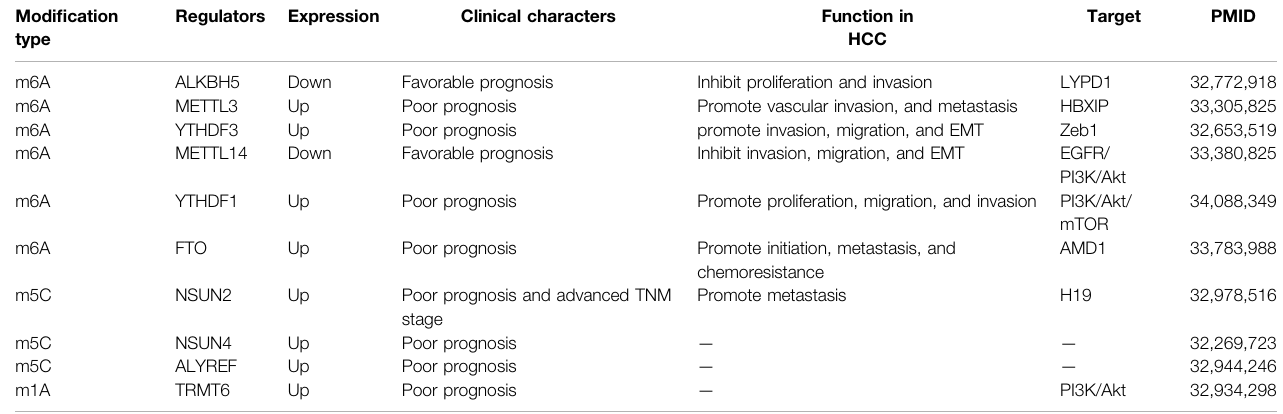
TABLE 2 | The association of m6A, m5C, and m1A methylation in HCC.